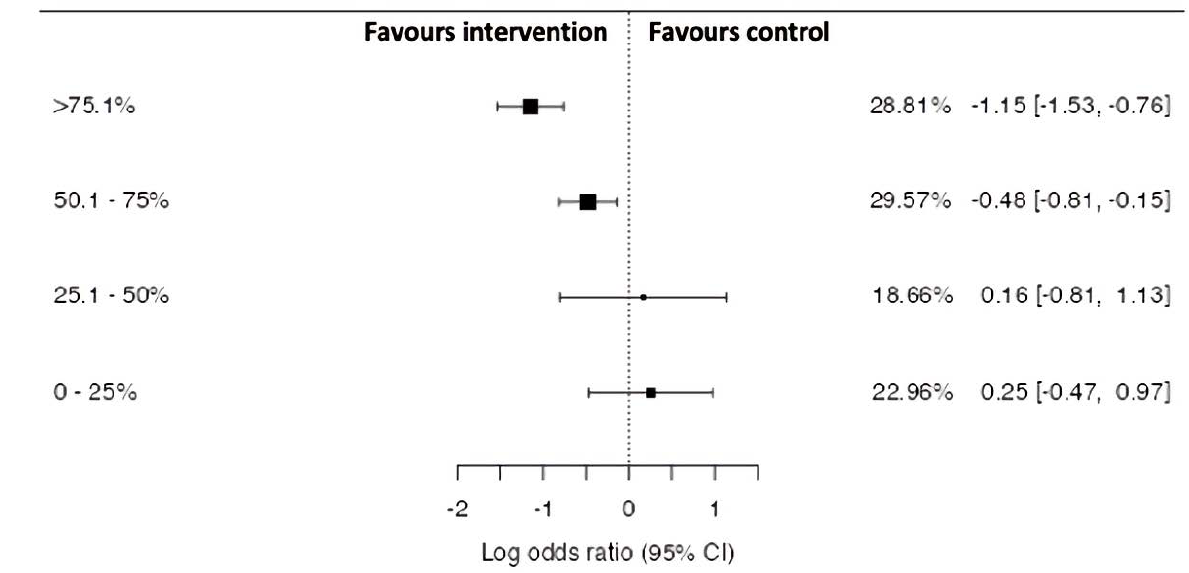
Figure 2. Comparison of intervention compliance rates on hamstring strain injury risk odds ratios based on grouped study estimates, 95% CI and WMD%.